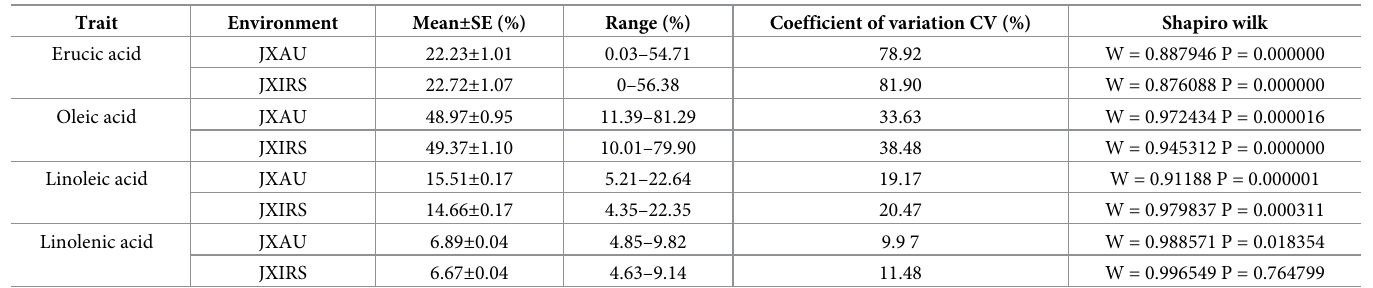
Table 1. Statistical analysis of four fatty acids of rapeseed.